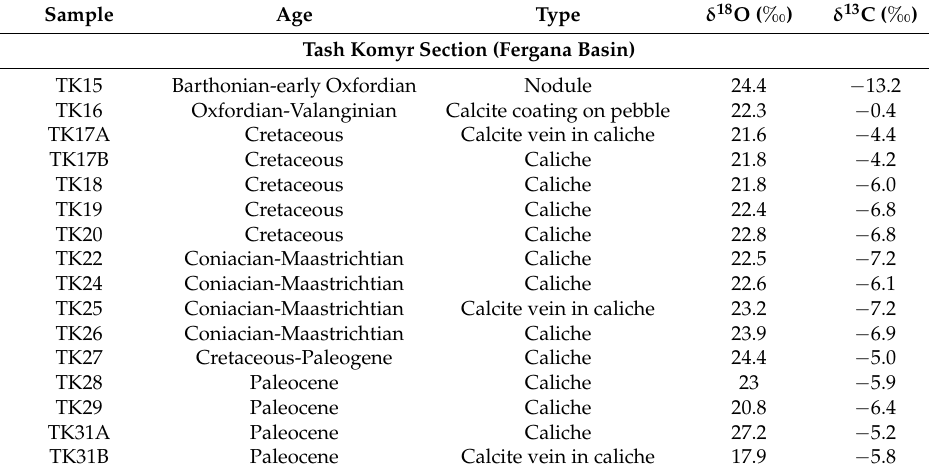
Table 1. Oxygen and carbon isotope compositions of the samples analyzed in this study. Samples marked with a star (*) are from [16]. δ 18 O values are relative to VSMOW and δ 13 C values to